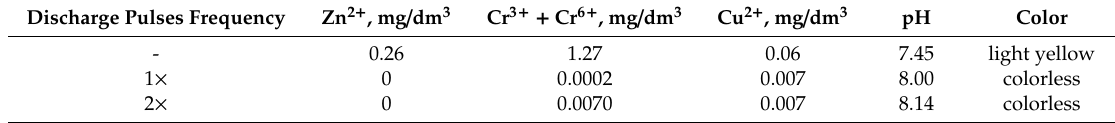
Table 5. The e ff ectiveness of galvanic purification on changing the discharge pulse frequency.